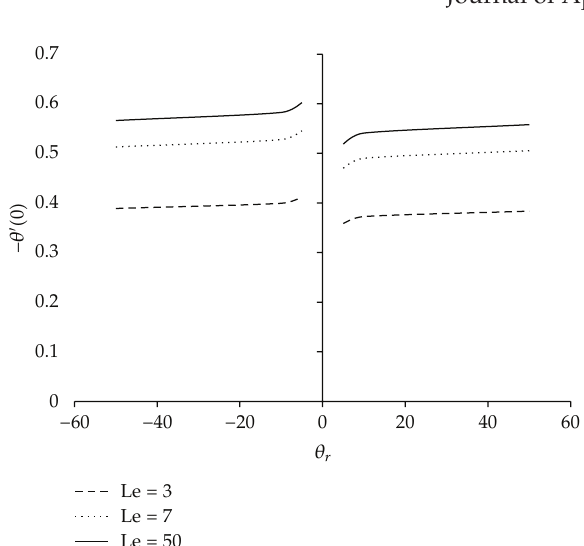
Figure 10: E ff ect of Lewis number Le on the rate of heat transfer for di ff erent values of θ r for Du (cid:8) 0 . 03, Sr (cid:8) 2, N (cid:8) 1, Pr (cid:8) 0 . 71, and Sc (cid:8) 0 . 1.